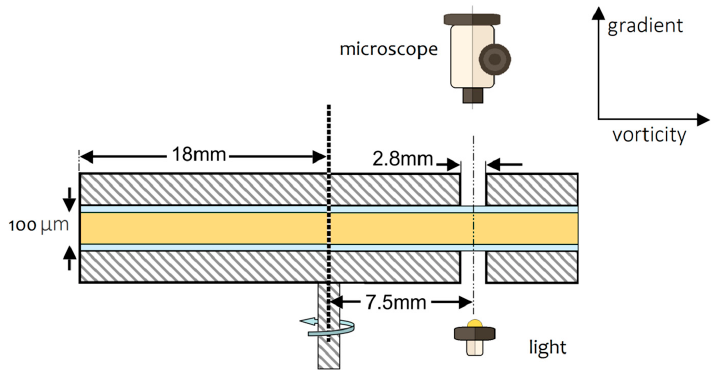
Figure 1. Schematic description of the shearing device: parallel-plate geometry with a diameter of 36 mm and a gap of 100 µm. The observation plane is described by the velocity–vorticity axes. The motion of the lower disc imposes a simple shearing stress field on the sample.